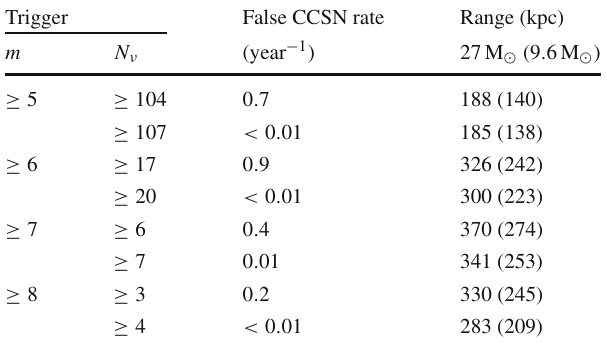
Table 4 False CCSN detection rate and range of supernova detection (50% probability) for different values of m and N ν (see trigger condi- tions in Sect. 4; Δ t coin = 20ns, Δ T SN = 10s)